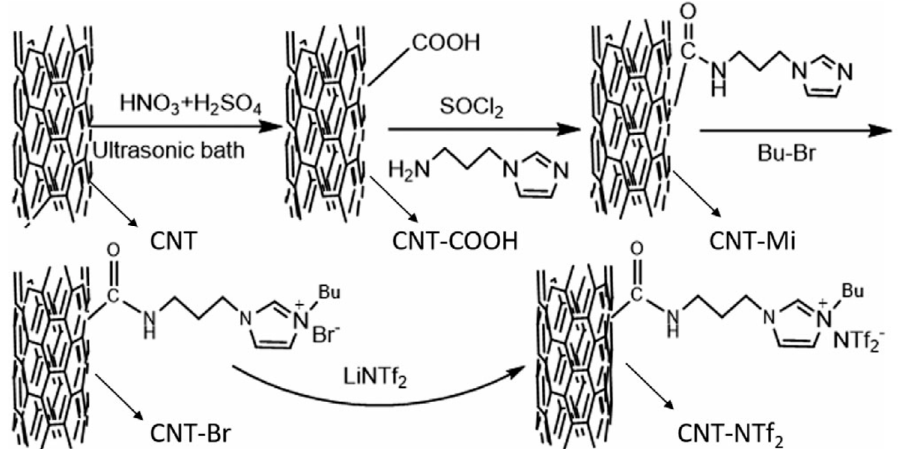
Figure 2. Synthetic route of ionic liquids functionalized CNTs. With permission [26].